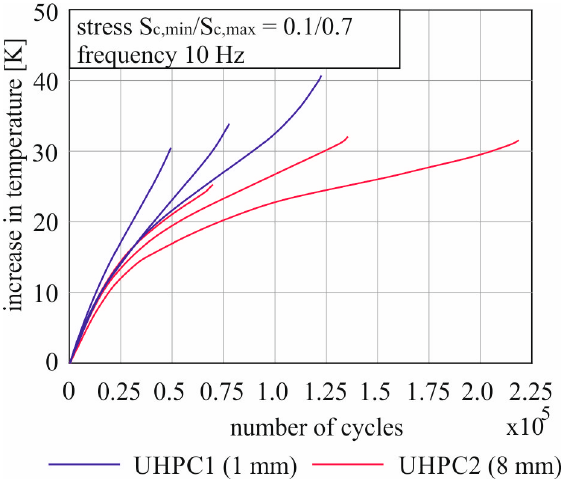
Figure 7. Temperature development of specimens made of UHPC 1 an UHPC 2; test conditions: test frequency f P = 10 Hz, relation between lower and upper stress level S c,min /S c,max = 0.1/0.7.